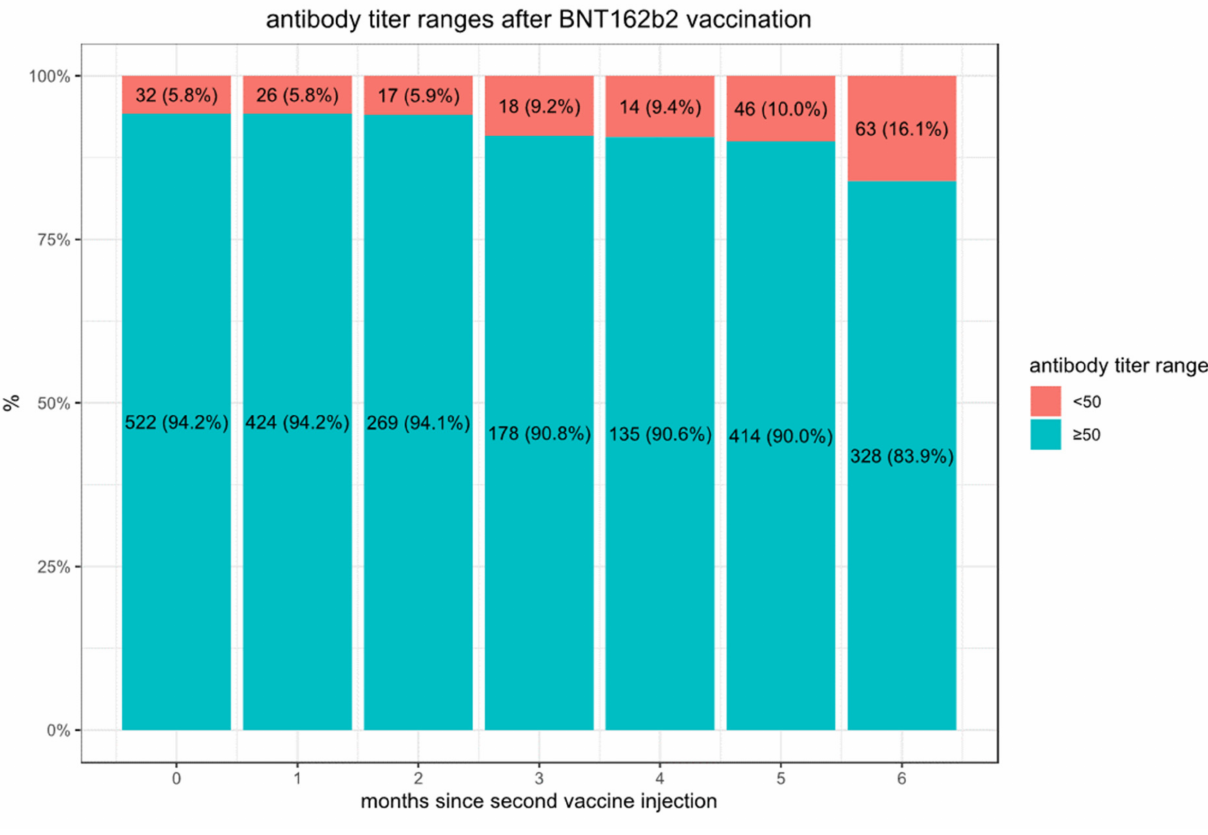
Figure 1. Proportions of doubly vaccinated individuals with antibody titers below the protective threshold of